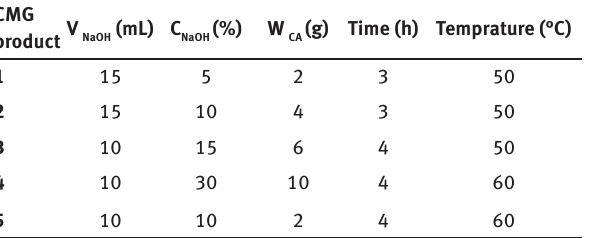
Figure 2: Synthesis of carboxymethyl guar (CMG). Table 1: Carboxymethylation of guar gum following the method [19]. CMG